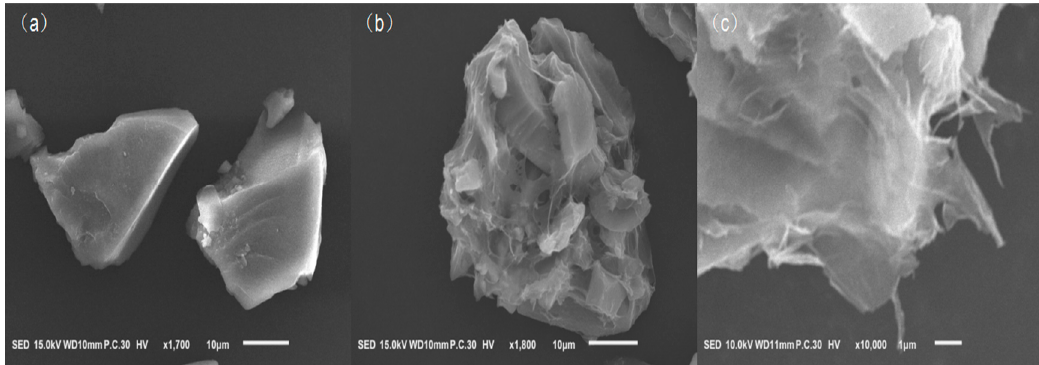
Figure 3. ( a ) SEM images of SG-PEI ( b ) SEM images of SG-PEI/rGH ( c ) the magnified SEM images of SG-PEI/rGH